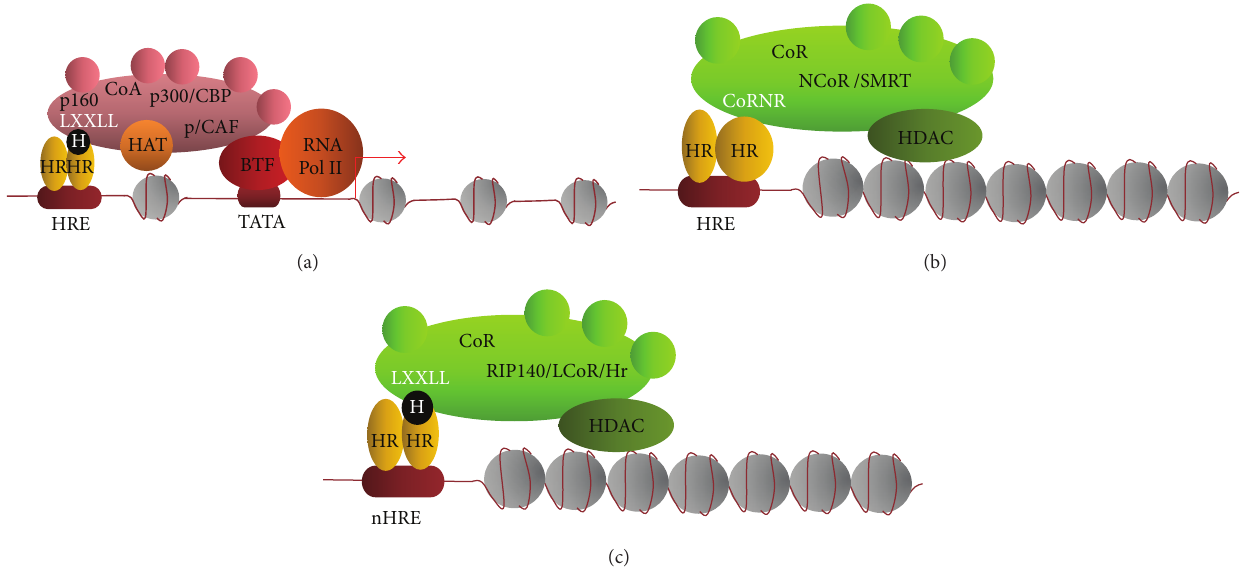
Figure 5: Coactivators, corepressors, chromatin, and regulation of transcription. (a) The coactivator complex consists of many proteins, including proteins with the LXXL (L: leucine, X: any amino acid) motif by which they bind to the hormone-activated nuclear receptor. Histone acetyltransferase activity might be presented by more than one protein of this complex. Decondensation of the chromatin structure upon histone acetylation and a direct interaction of the coactivator complex with basal transcription factors result in transcription activation. (b) In the absence of the hormone, receptor conformation promotes the binding of a multiprotein corepressor complex. Binding of the receptor to this complex occurs by the LXXI/HIXXXI/L (L: leucine, X: any amino acid, I: isoleucine, and H: histidine) motif present in a corepressor protein. The complex includes class I or class II histone deacetylase. Histone deacetylation leads to the condensation of chromatin and, as a result, limits the access of transcription factors to the DNA. As a result, transcription is inhibited. (c) Some corepressor proteins contain the LXXL motif and preferentially bind to the receptors activated by the hormone. Next, by the recruitment of the corepressor complex, including histone deacetylase, they stabilize tight chromatin structure and repress transcription. H: hormone, HR: nuclear hormone receptor, HRE: hormone response element, nHRE: negative hormone response element, CoA: corepressor complex, p160, p300/CBP, and p/CAF: coactivator proteins, LXXL: coactivator protein motif involved in receptor binding, HAT: histone acetyltransferase, CoR: corepressor complex, NCoR/SMRT: classic corepressor complexes, CoRNR: LXXI/HIXXXI/L corepressor protein motif involved in receptor binding, HDAC: histone deacetylase, RIP140/LCoR/Hr: nonclassical corepressor proteins preferentially binding to hormone-activated receptors, BTF: basal transcription factors, and RNA Pol II: type II RNA